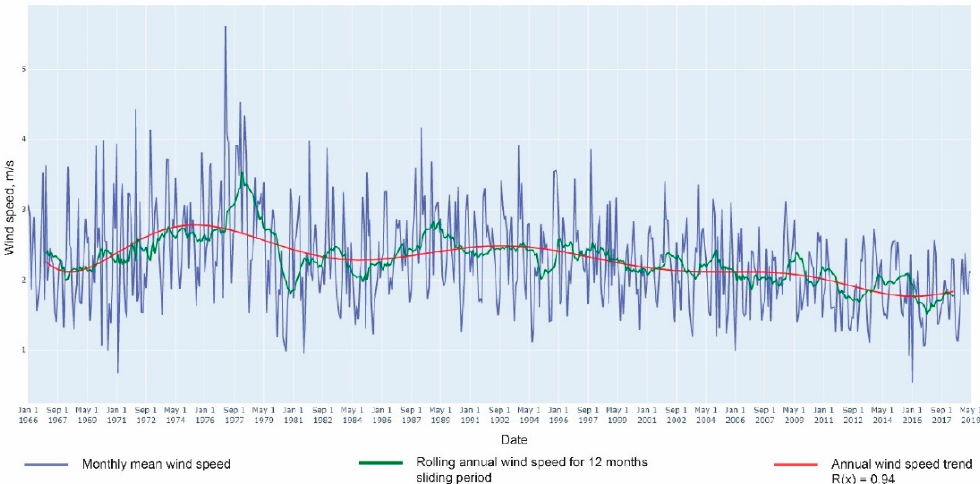
Atmosphere 2020 , 11 , 1375 Figure 3. The average monthly wind speeds for the period from 1966 to 2019. Figure 3. The average monthly wind speeds for the period from 1966 to 2019.